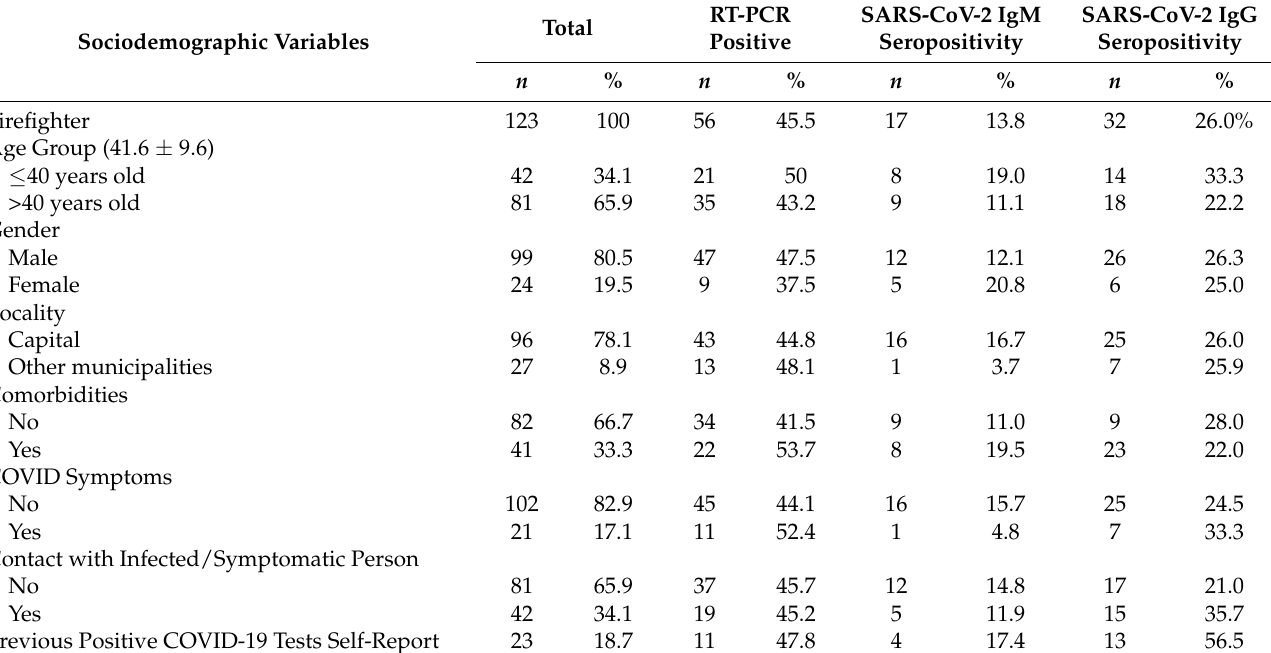
Table 1. Demographic and health profile of the firefighters participating in the